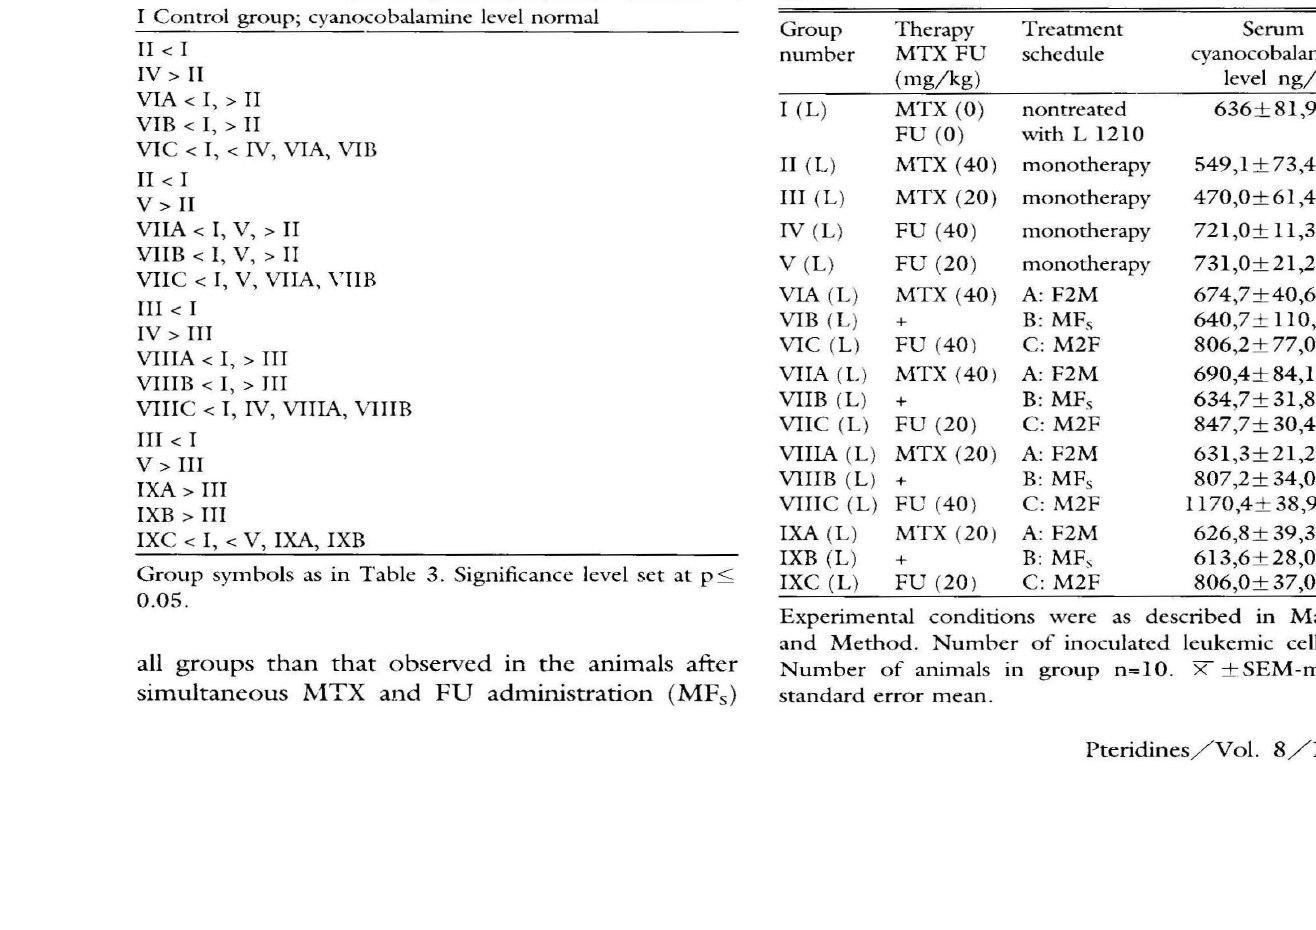
Table 4 . Statistically significant differences of serum cyano cobalamine levels between the groups of healthy BDFl mice after adrninistration of MTX, FU and combined thera